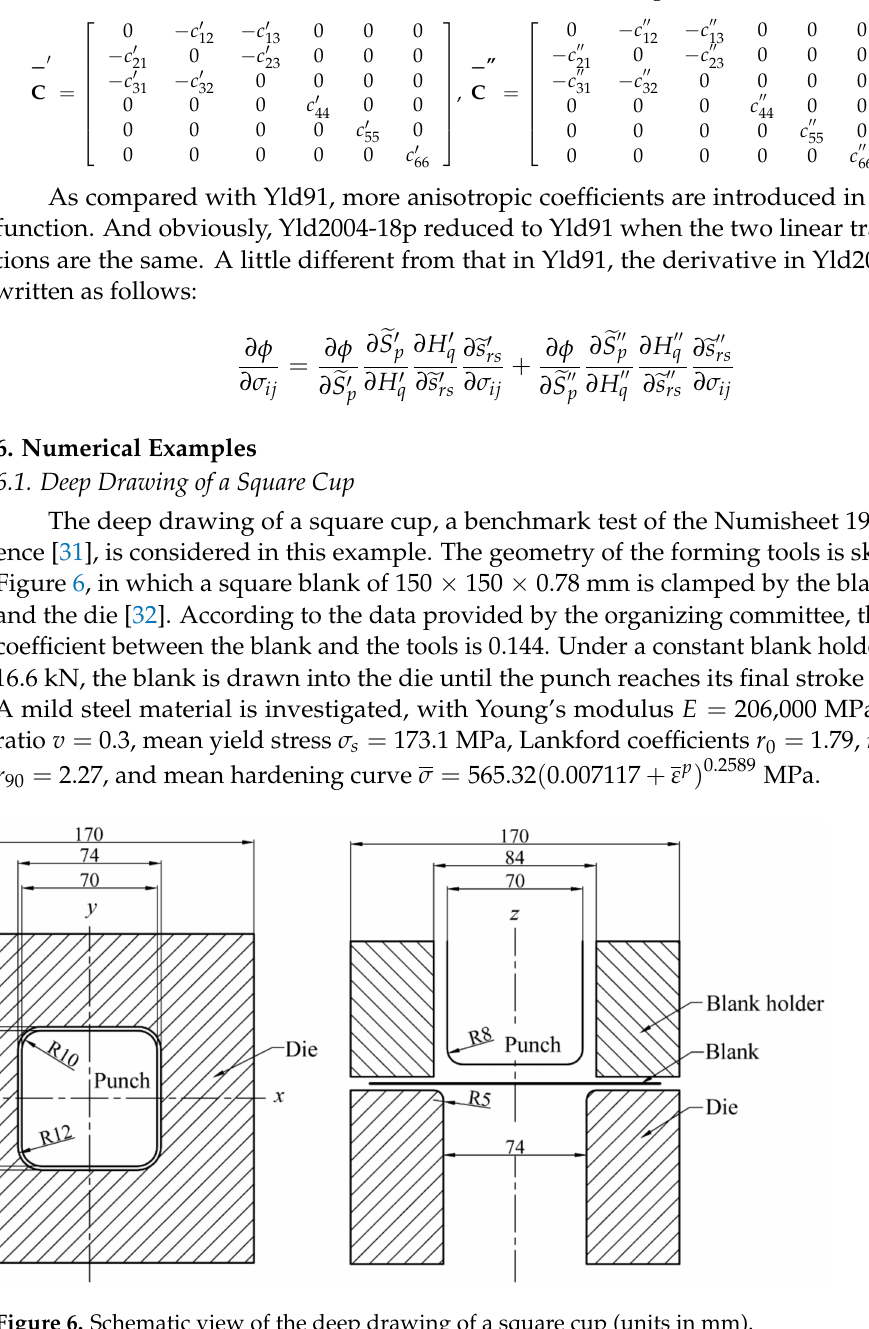
Figure 6. Schematic view of the deep drawing of a square cup (units in mm). The proposed solid-shell element with five integration points along the thickness direction was adopted to analyze the drawing process. To validate the performance of the solid-shell element in adaptive mesh subdivision, two simulations were conducted for comparison. In the first simulation, the blank was initially discretized by 35 × 35 solid- shell elements with the adaptive mesh subdivision utilized during the forming process. The highest subdivision level was set as 1. And in the second simulation, the blank was discretized by 70 × 70 elements, with the element number kept constant during the simulation. Aiming at capturing the anisotropic behavior of the metal sheet, the Hill48 yield function was incorporated in the two